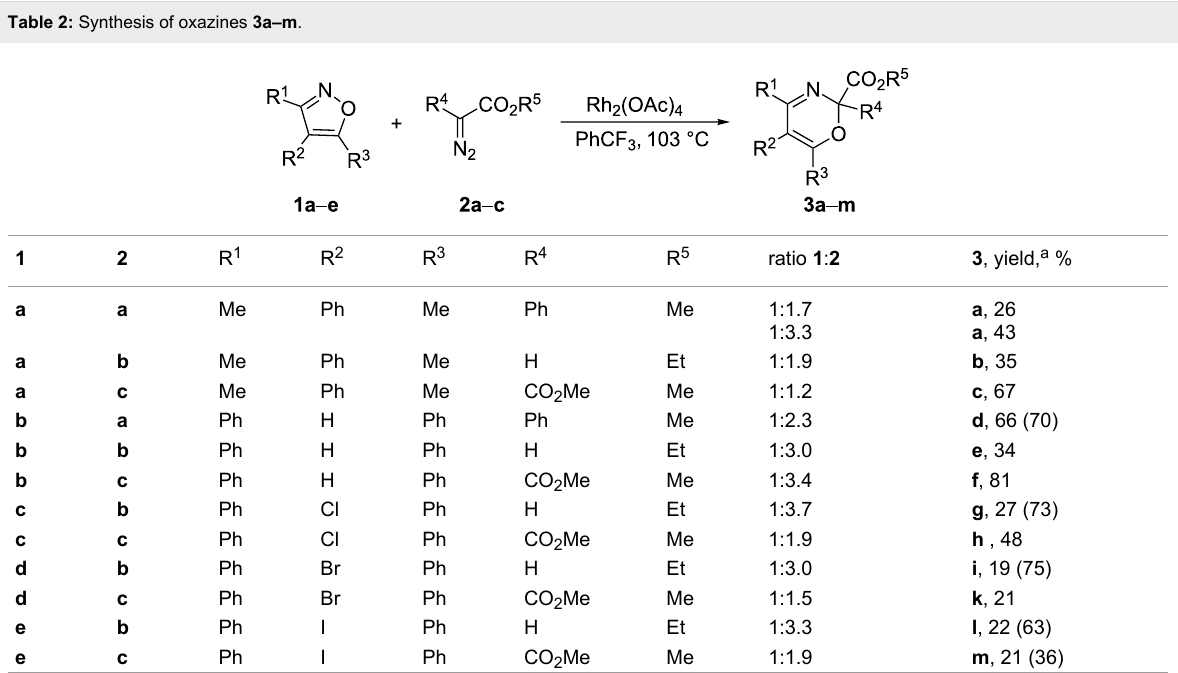
Table 2: Synthesis of oxazines 3a–m